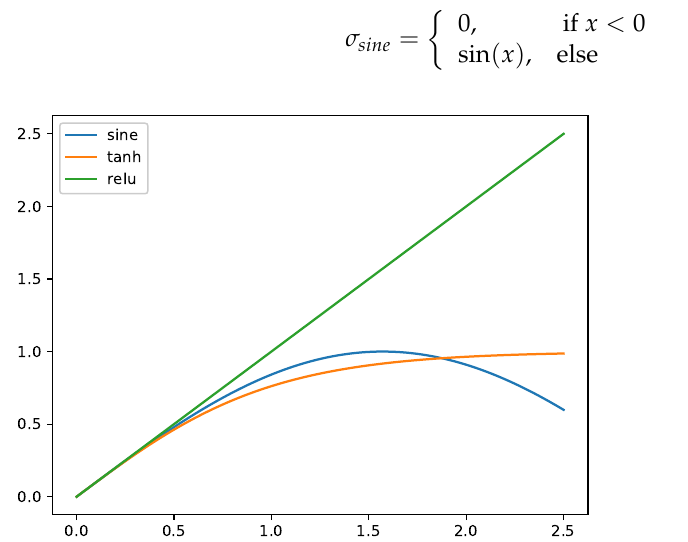
Figure 3. Activation functions. The sine activation behaves similarly to the hyperbolic tangent activation for | x | < π